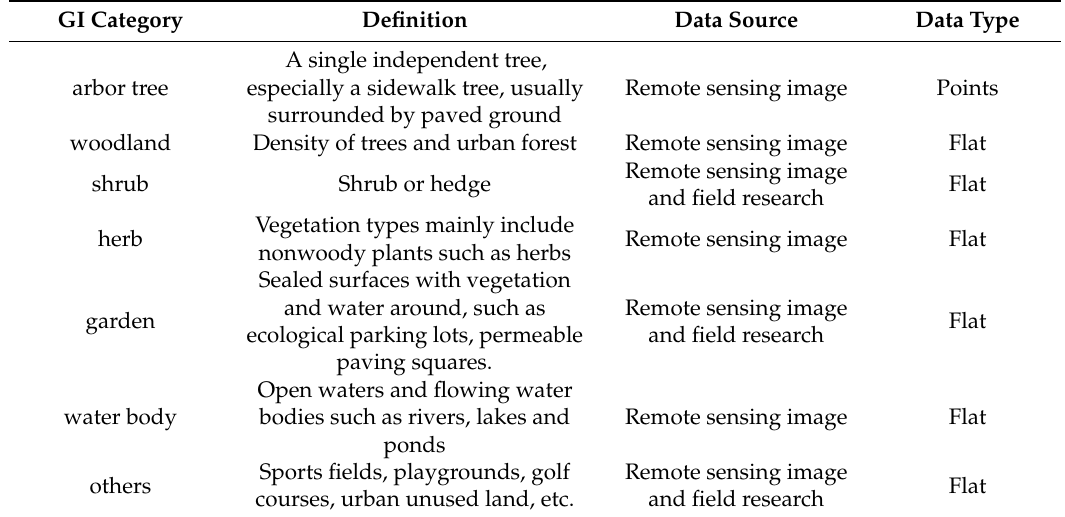
Table 2. Green infrastructure (GI) category description.